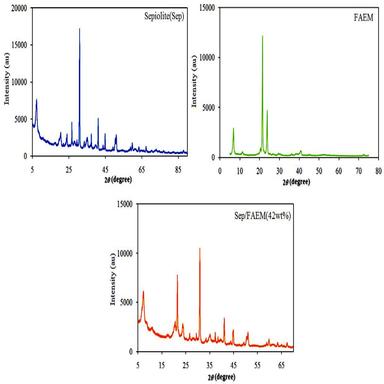
XRD analysis results of Sep, FAEM and Sep/FAEM(42 wt%).